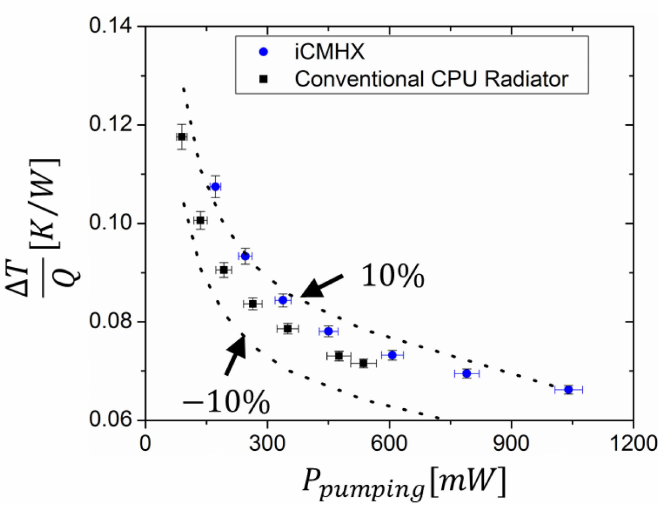
Figure 13. Comparison of experimental ∆ T/Q for different pumping powers P pumping for both iCMHX and conventional CPU